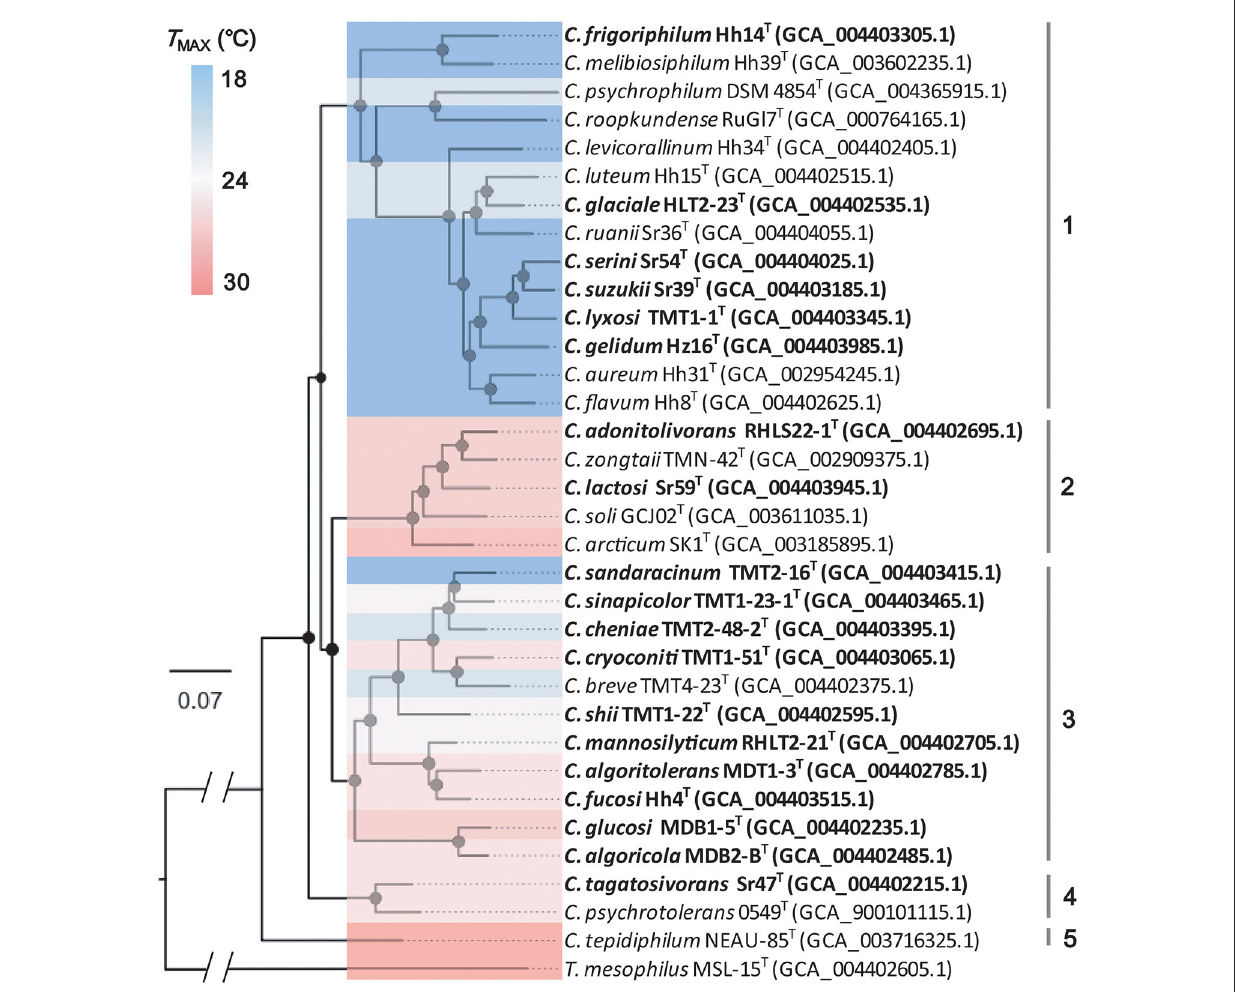
FIGURE4 Phylogeny of the genus Cryobacterium using the maximum-likelihood algorithm based on the 265 concatenated single-copy gene sequences. Accession numbers of the genomic sequences are given in parentheses. Bootstrap values > 70% are marked as black dots on the internal nodes. The bar represents 0.07 nt substitutions per